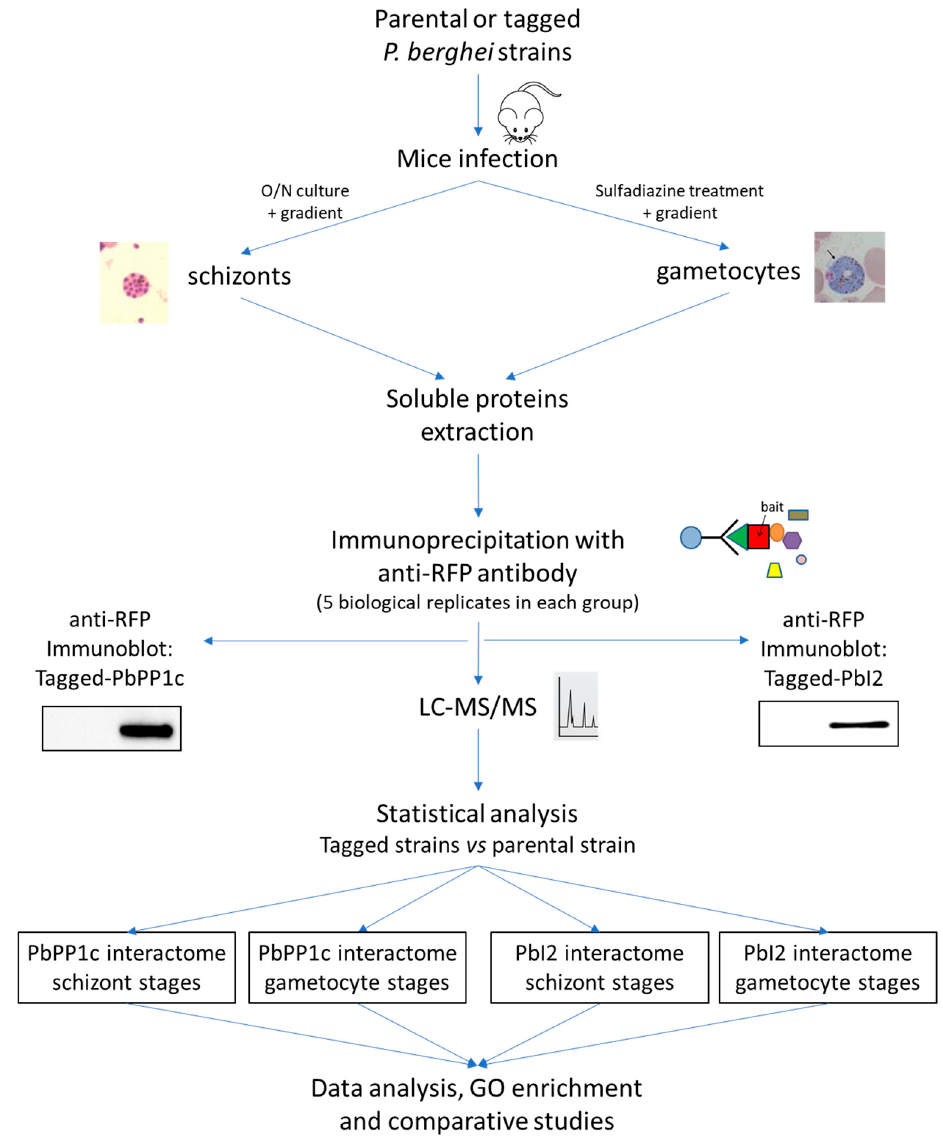
Figure 1. Workflow and study overview. Schizont and gametocyte stages were prepared from PbWT GFP, PbPP1c–mCherry, and PbI2–mCherry parasites. Immunoprecipitation was performed with anti-RFP antibody on 5 different biological replicates of schizonts and gametocytes extracts prepared from each parasite strain (PbWT, PbPP1c–mCherry, and PbI2–mCherry). The presence of mCherry-tagged PbPP1c and PbI2 was checked in the immunoprecipitated fractions (control wild-type vs. tagged proteins) before MS. Proteomic and statistical analyses (detailed in Section 3) allowed for the identification of the interactome of PbPP1c and PbI2 in schizont and gametocyte stages that were further analyzed for GO enrichment, STRING networks, and comparative analyses.